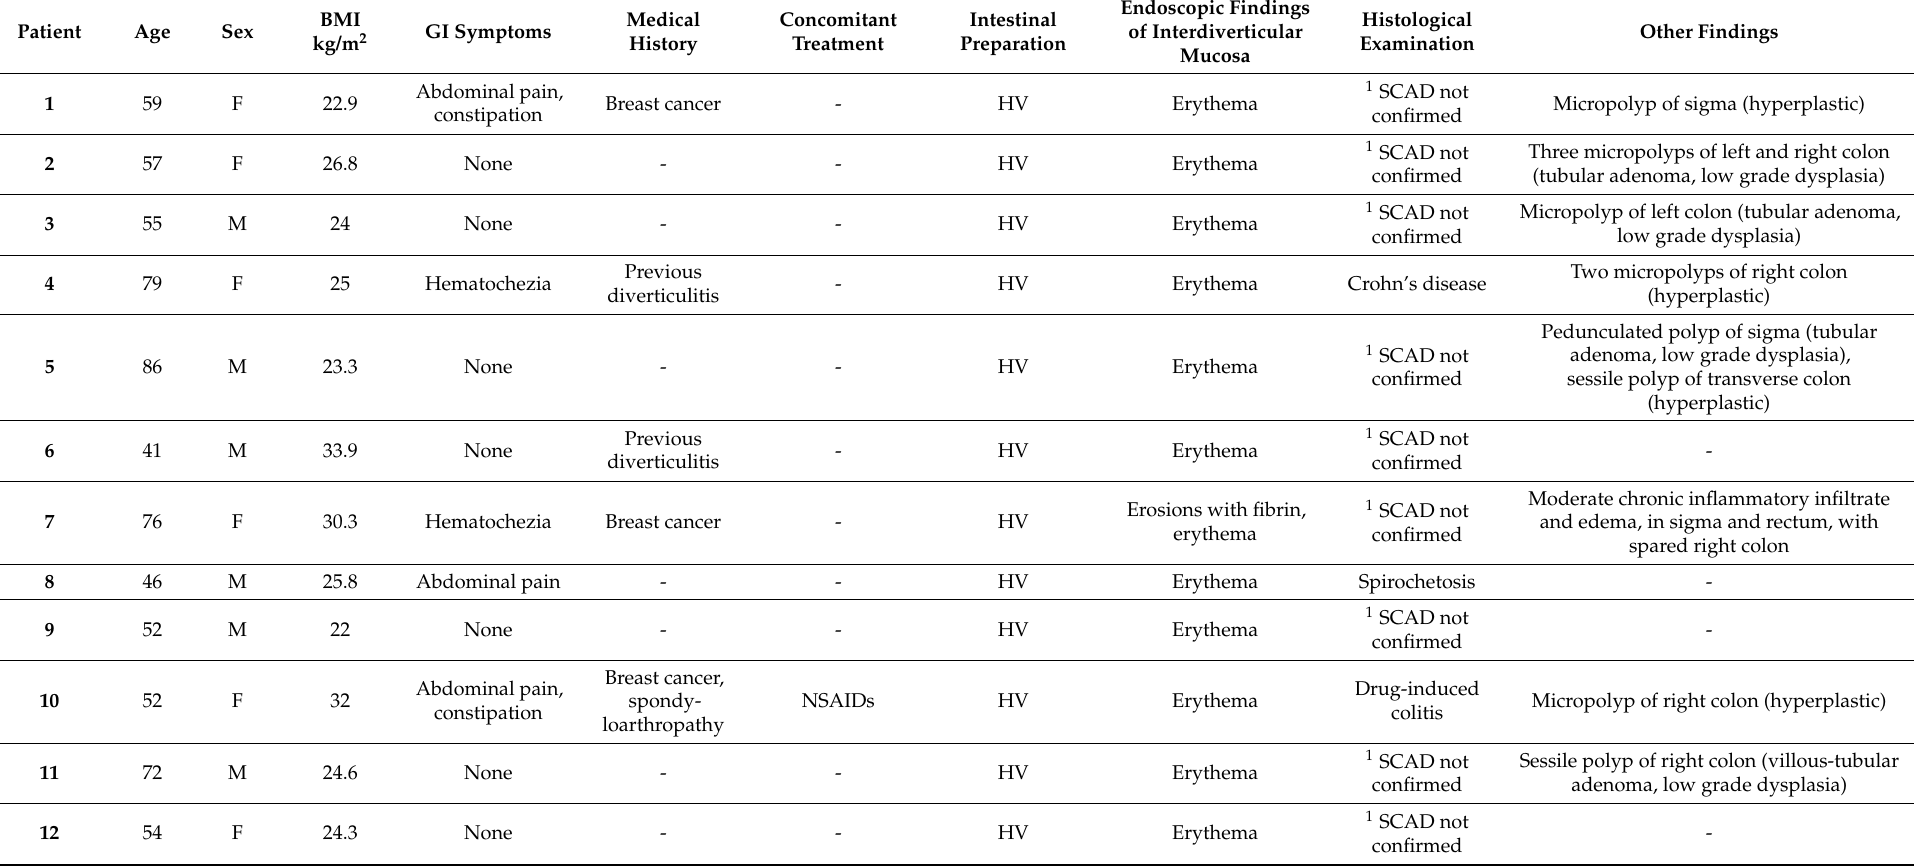
Table 1. Demographic, clinical features and endoscopic findings in patients with suspected